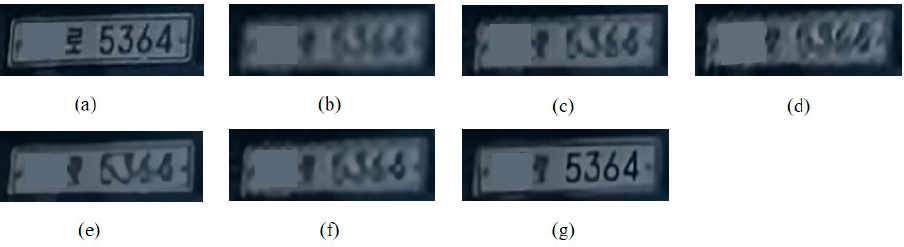
Figure 7. SR results of the second plate image (4 × ). ( a ) HR (140 × 48), ( b ) Bicubic, ( c ) DRN, ( d ) MZSR, ( e ) USRNet, ( f ) DBPN, ( g ) Proposed. Two characters were masked due to privacy policies.